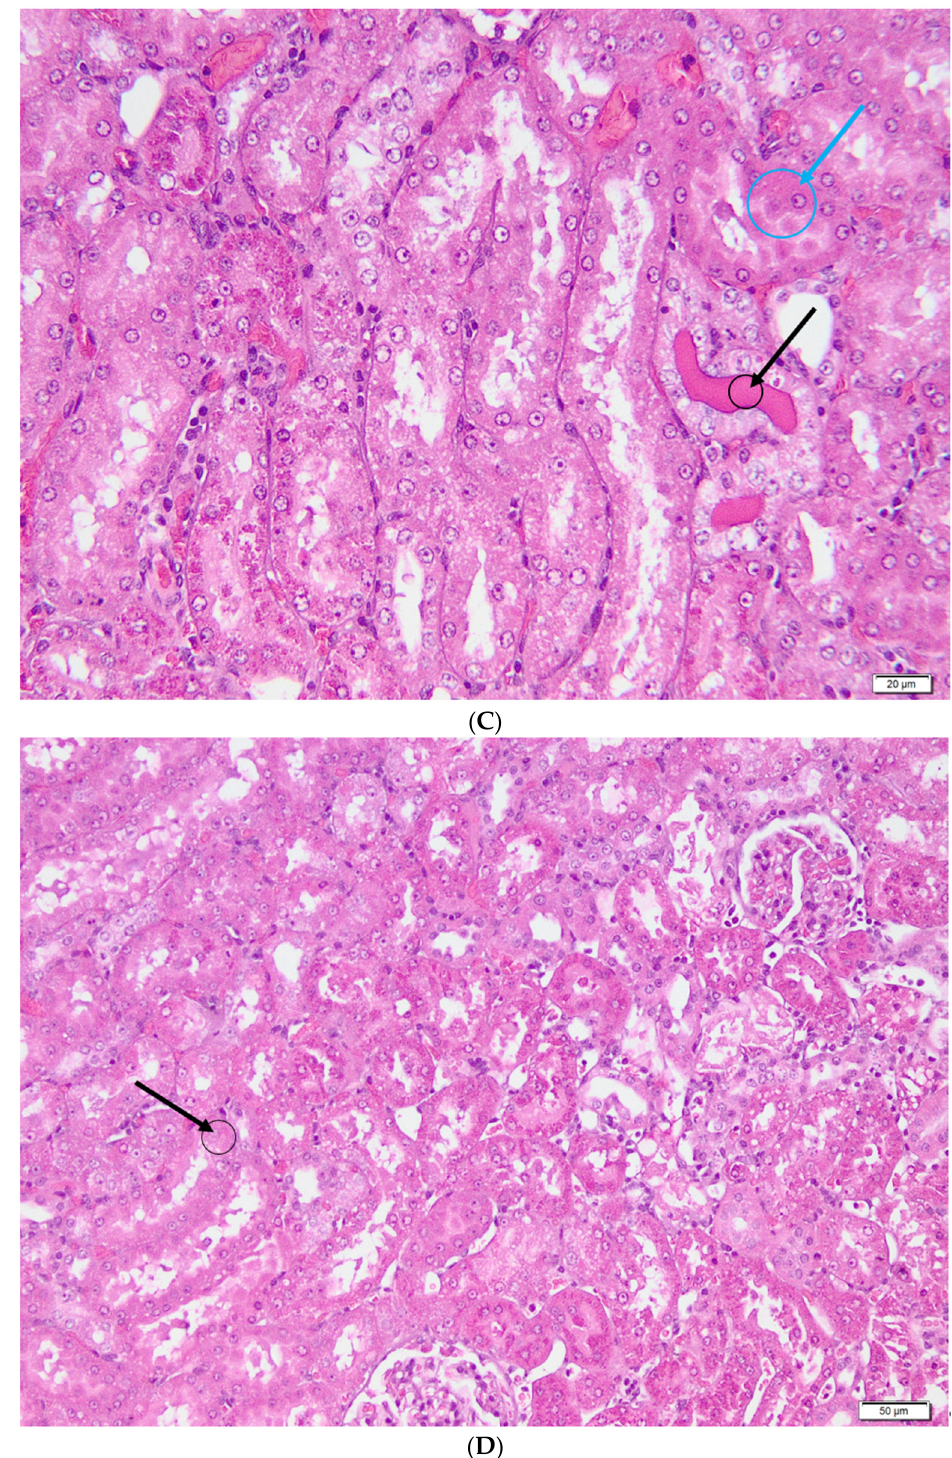
Figure 6. Vitamin C group — histological aspects. ( A ) — Tubular epithelial cells with pycnotic nuclei (caryorexia); ( B ) — Discrete interstitial inflammatory infiltrate (black arrow) and rare aspects of necrosis (red arrow); ( C ) — Intracellular (blue arrow) and extracellular (black arrow) hyalinosis; ( D ) — Discrete hydropic degeneration.